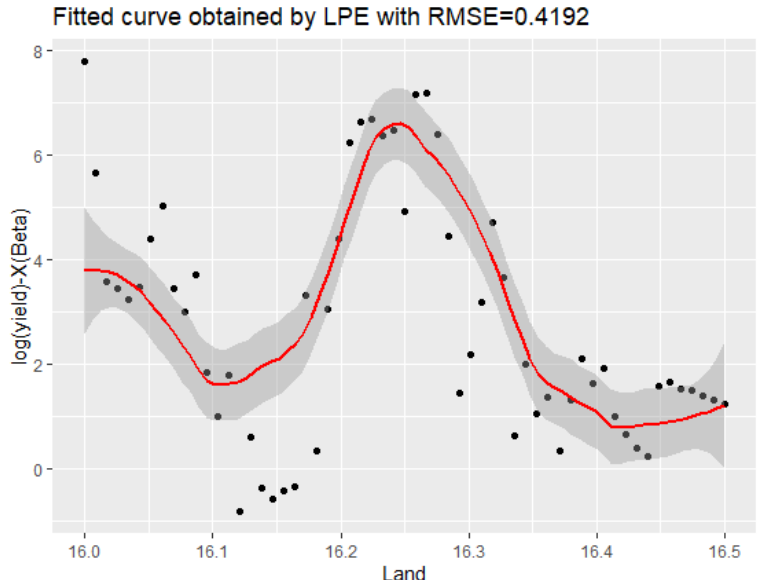
Figure 4. Fitted curve f ( Land t ) against ( log ( Yield ) − X β ) for the nonparametric component with RMSE score.